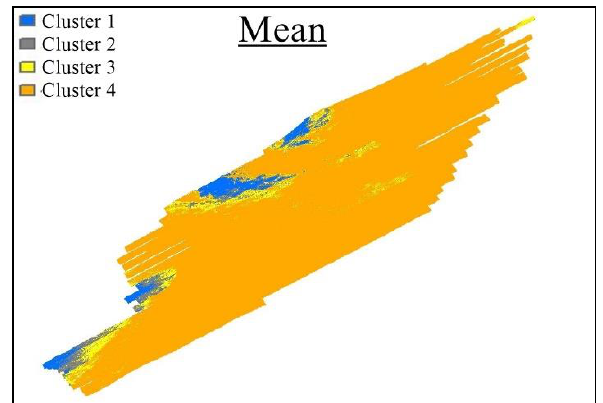
Figure 7: GLCM Mean Cluster Map Cross tabulation analysis (Tables 3-6 and Figures 8-11)